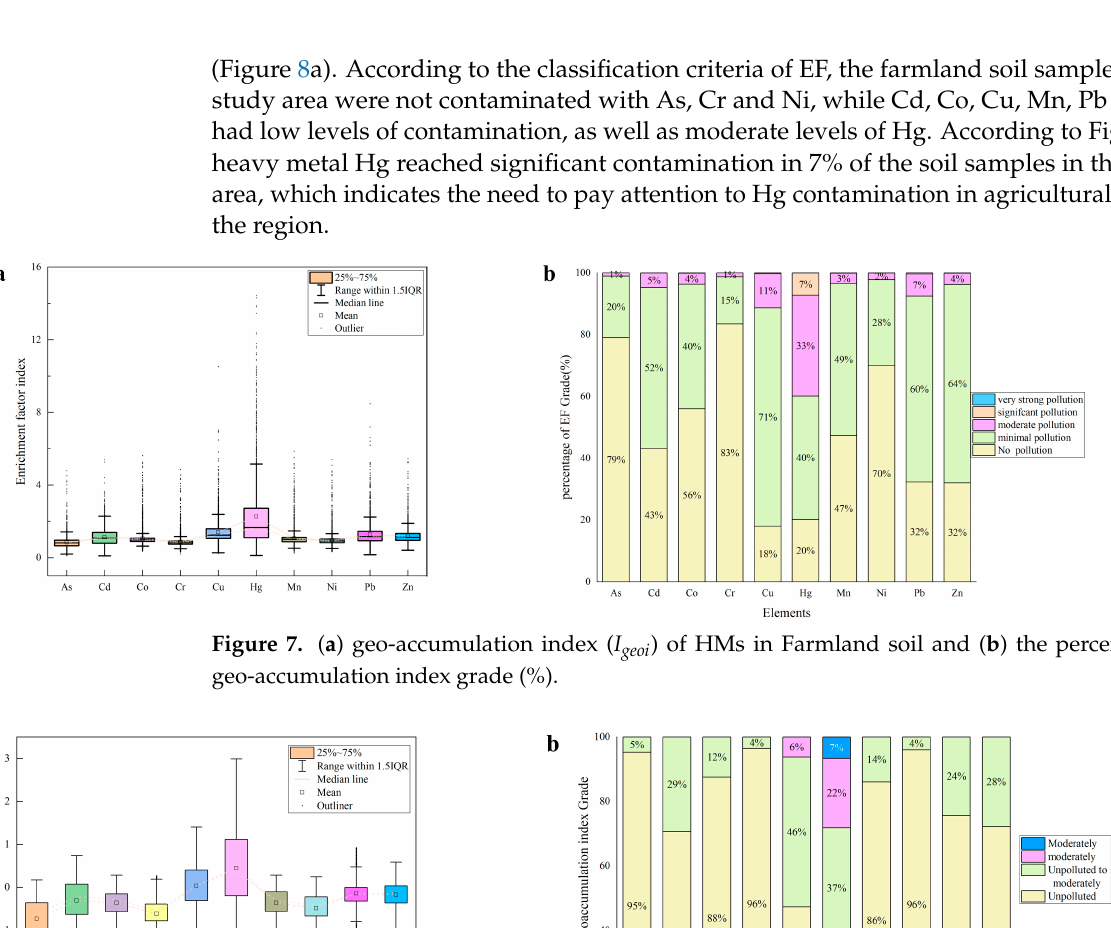
Table 6. Description of the results of the potential ecological risk index.